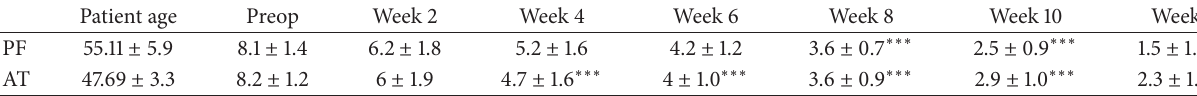
Table 1: Baseline statistics and time course postoperative visual analogue pain scores (VAS) for patients with either plantar fasciosis (PF) or Achilles tendinosis (AF). Data is presented as mean with SD. ∗∗∗ 𝑝 < 0.001 versus preop VAS (mean age compared with Mann-Whitney 𝑈 -test).